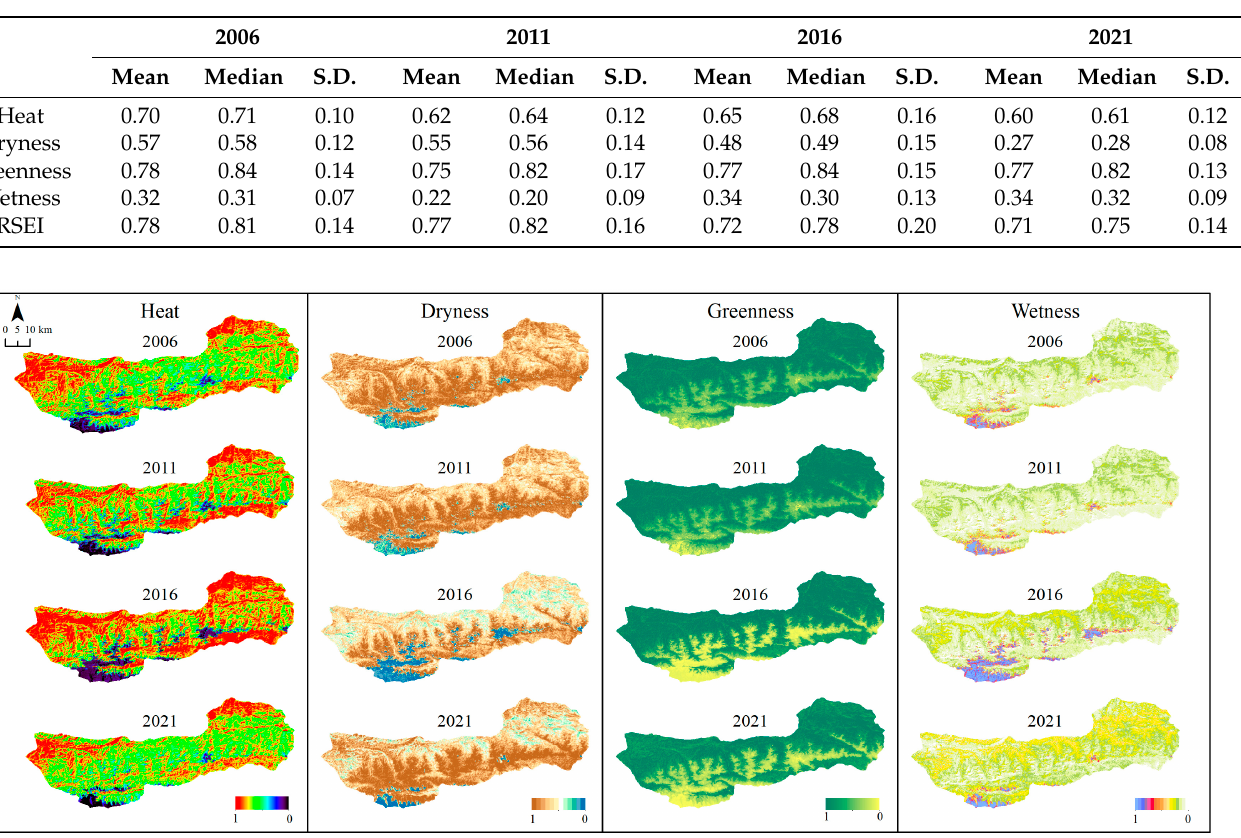
Table 3. Statistics of used factors from 2006 to 2021.